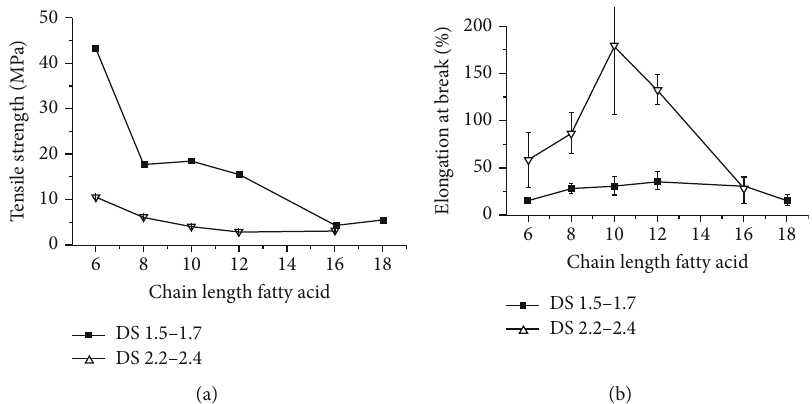
Figure 5: Tensile strength (a) and elongation at break (b) depending on the degree of substitution (DS) and type of fatty acid [25].